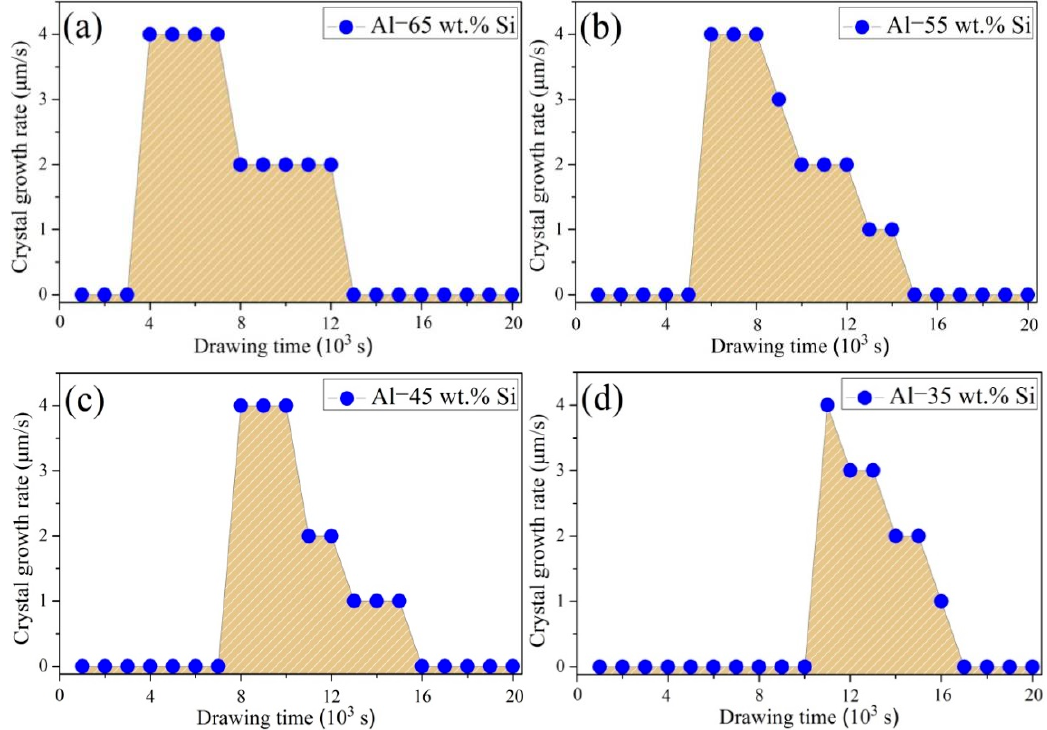
Figure 9. Growth rates of the Si-rich layers: ( a ) Al-65 wt.% Si, ( b ) Al-55 wt.% Si, ( c ) Al-45 wt.% Si, and ( d ) Al-35 wt.% Si.